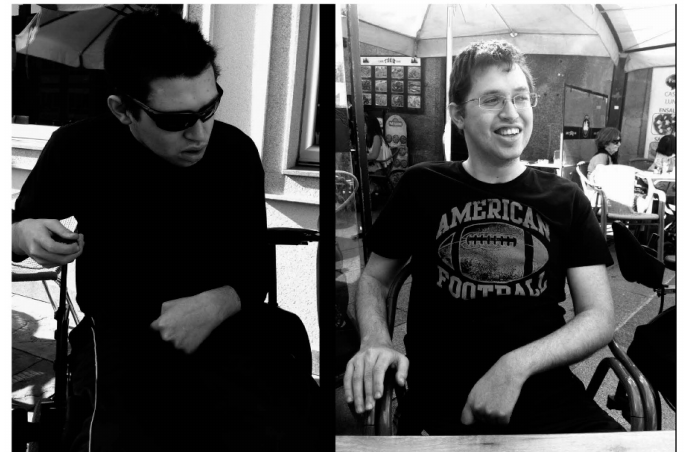
Figure 5. The changes: ( Left ) The patient two months after admission. Notice the weak control of head and trunk, the patient sitting on a wheel chair, the right and left arms flex and the irreducible carpal flex of the left wrist; ( Right ) The patient three and a half years later. Observe the patient sitting on a normal chair, the normal position of head, trunk and both arms, the corrected flex of both arms and the almost corrected flex of the left